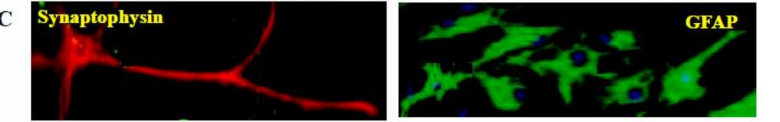
Figure 5. Pep-PP@Res exerted little toxic effect on the 2D+ cultured normal rat brain cells. ( A ). Bright field illustration of the normal rat brain tissue with cell outgrowth and without cell death (the inset) after 72 h of the 100 µ M Pep-PP@Res treatment. The cells marked with 1, 2 and 3 in the bright field image and the inset are the same viable cells without PI labeling. ( B ). The Calcein/PI cell viability assay (viable (green)/nonviable (red)) performed on the rat brain cells at the 0 h and 72 h timepoints of the Pep-PP@Res treatment, demonstrating the rarity of brain cell death. ( C ). Immunofluores- cent illustration of the intact synaptophysin-positive neurons and GFAP-positive glial cells in the 2D+ brain tissue culture treated with 100 µ M Pep-PP@Res for 72 h.